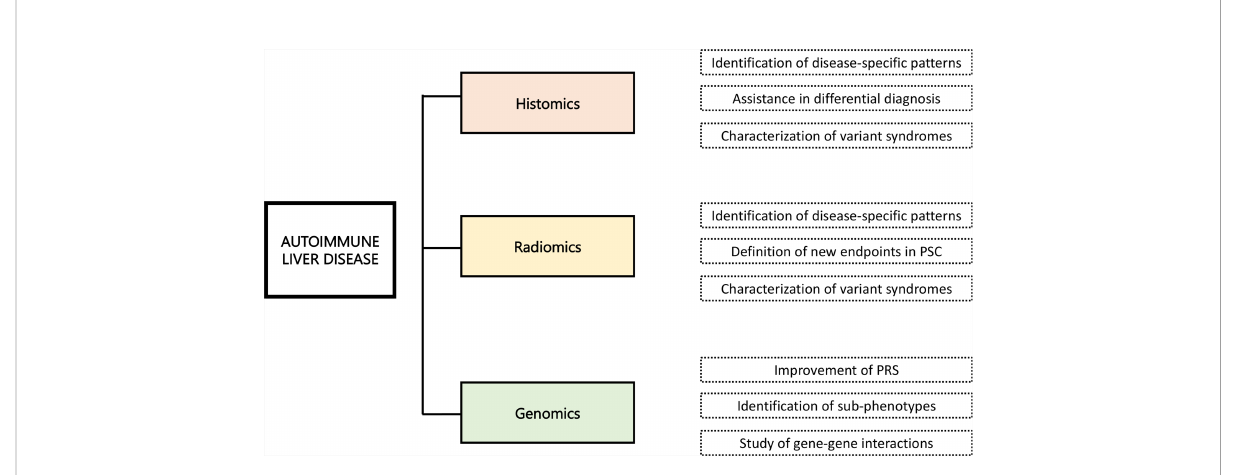
FIGURE 4 Future applications of arti fi cial intelligence in the fi eld of autoimmune liver